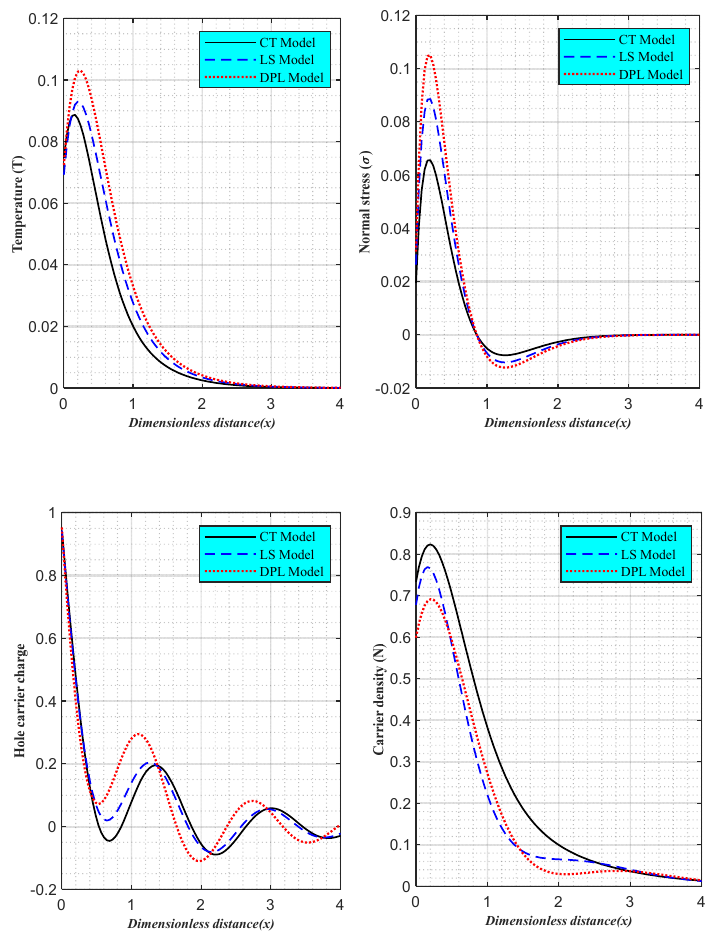
Figure 3. Under the in fl uence of the Hall current and laser pulses, the principal physical distribu- tions vary with distance in accordance with photo-electronic-thermoelasticity theories.